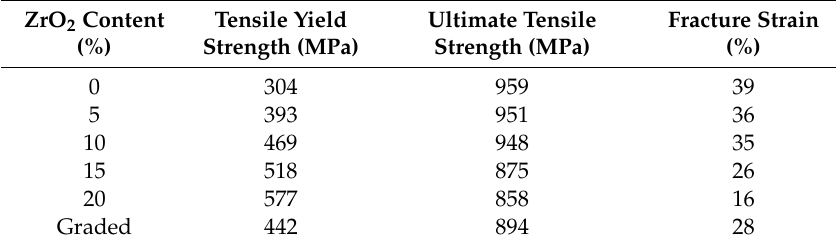
Table 2. Changes in mechanical properties with ZrO 2 Table 2 . Changes in mechanical properties with ZrO 2 content .